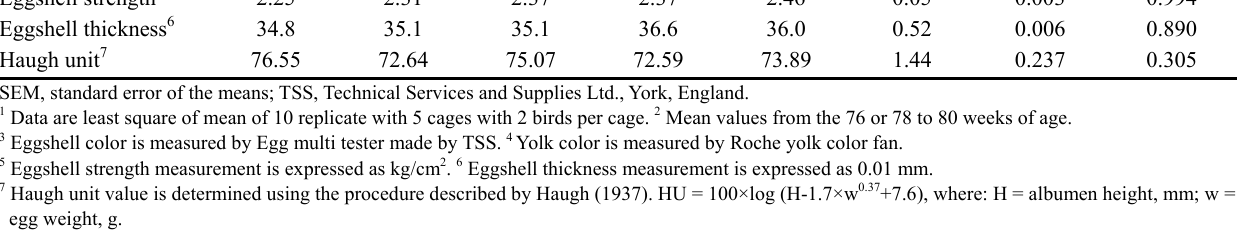
Table 4. Effect of graded levels of dietary calcium on egg and eggshell qualities in aged laying hens 1,2 Item